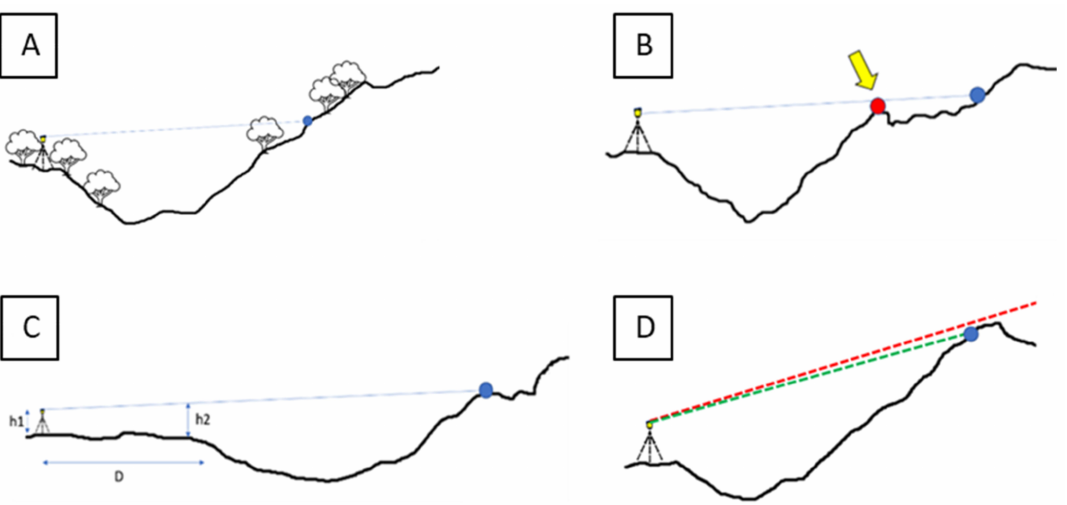
Figure 7. Field Stations. ( A ) Correct measurement condition with good LOS, vegetation is irrelevant. ( B ) Topological obstacle, the LOS can be too close to the topographical surface and CoordFinder can return false target coordinates. ( C ) LOS is tangent to the topographical surface, distance D and h2 are important to the CoordFinder setup buffer. ( D ) Target, too close to the relief top, can be missed with a small angle error and CoordFinder will miss the matching between LOS and topographical